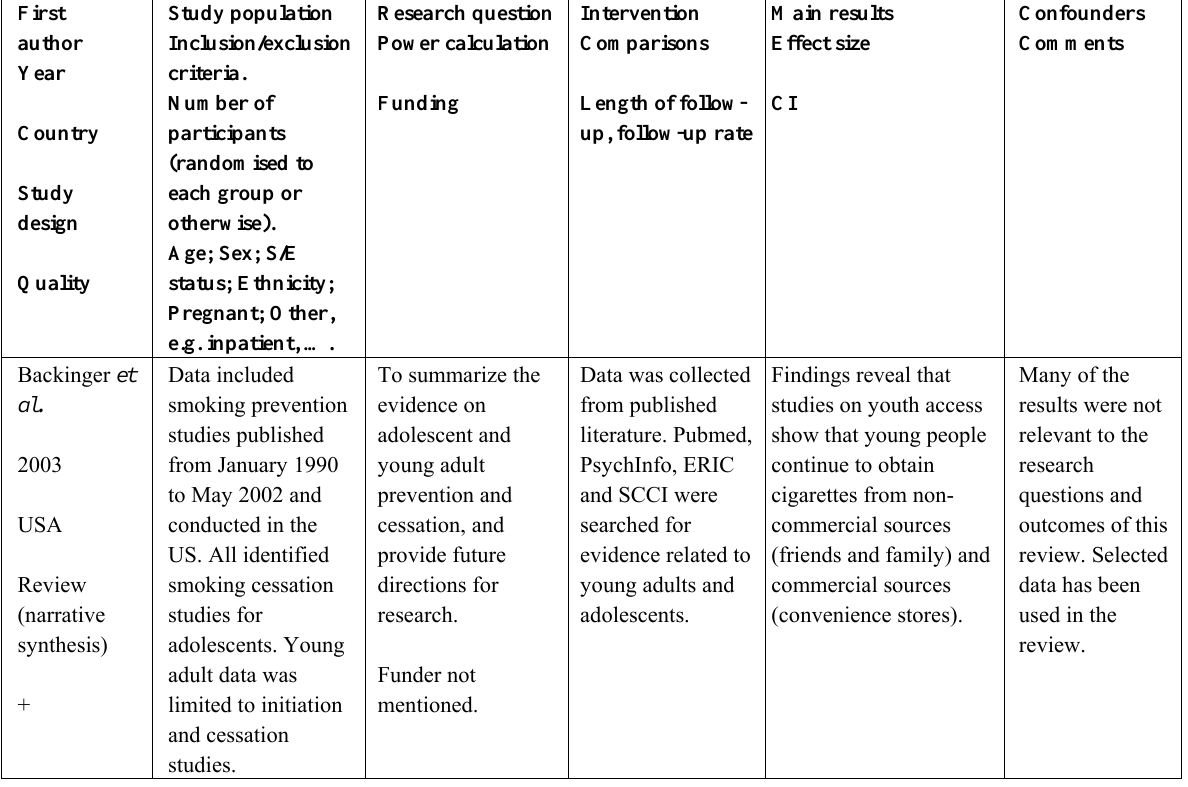
Table 2. Access Restriction Evidence